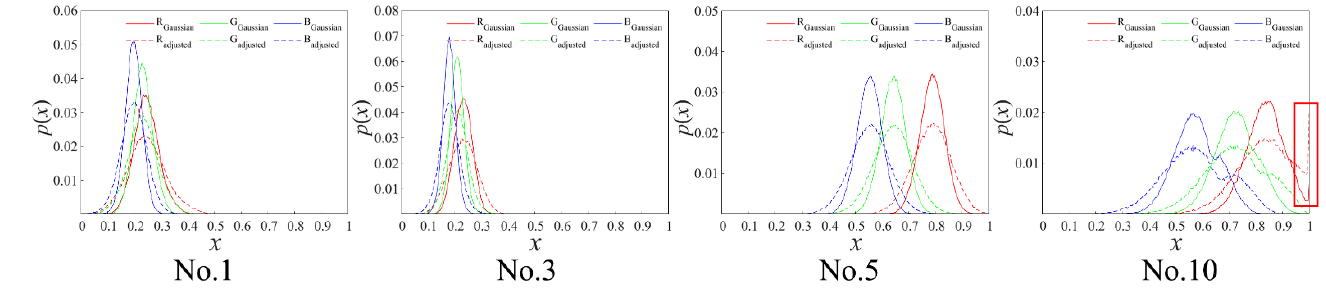
Figure 8. RGB histograms of the No.1, the No.3, the No.5, and the No.10 Gaussian images before and after the adaptive color adjustment at the unified 1.5 value of α c .